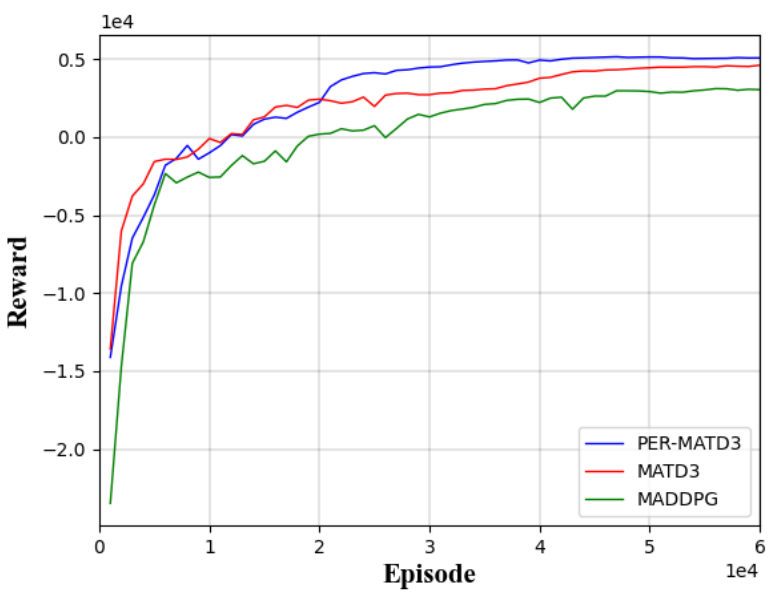
Figure 6. Episode average rewards.